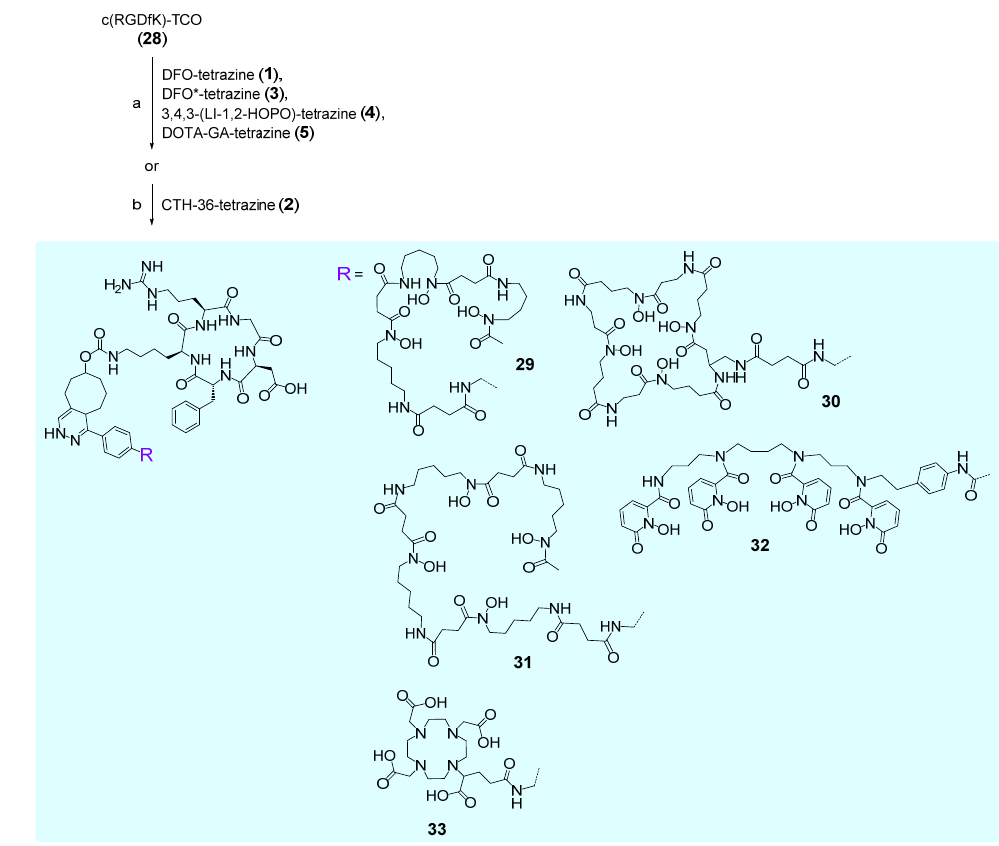
Scheme 17. Schematic depiction of the synthesis pathway towards the chelator–peptide conjugates 29 – 33 . Conditions: (a) 1.1 eq. chelator tetrazine ( 1 , 3 – 5 ), DMSO/H 2 O (1/1, v / v ), yields: 78% ( 29 ), 59% ( 31 ), 84% ( 32 ) and 70% ( 33 ); (b) 1.4 eq. 2 , DMSO, 65% ( 30 ).